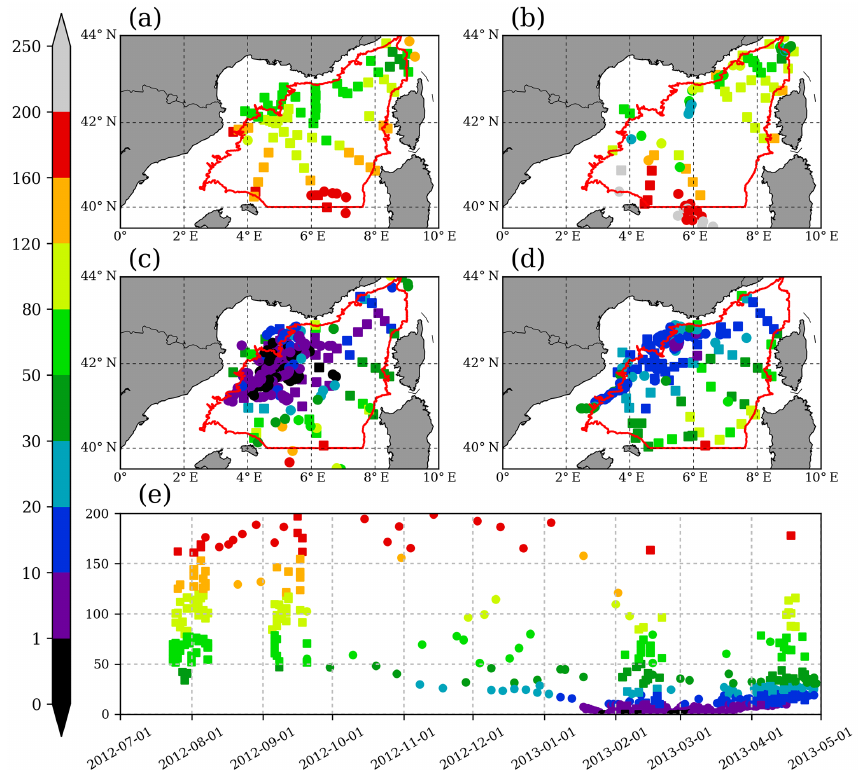
Figure 3. Stratification index at 1000m derived from CTD (squares) and ARGO (dots). Observations during (a) summer 2012 (MOOSE), (b) autumn 2012 (DOWEX), (c) winter 2013 (DEWEX leg 1) and (d) spring 2013 (DEWEX leg 2). (e) Time series of the stratification index at 1000m. The red contour corresponds to the convective area defined in Sect. 3.